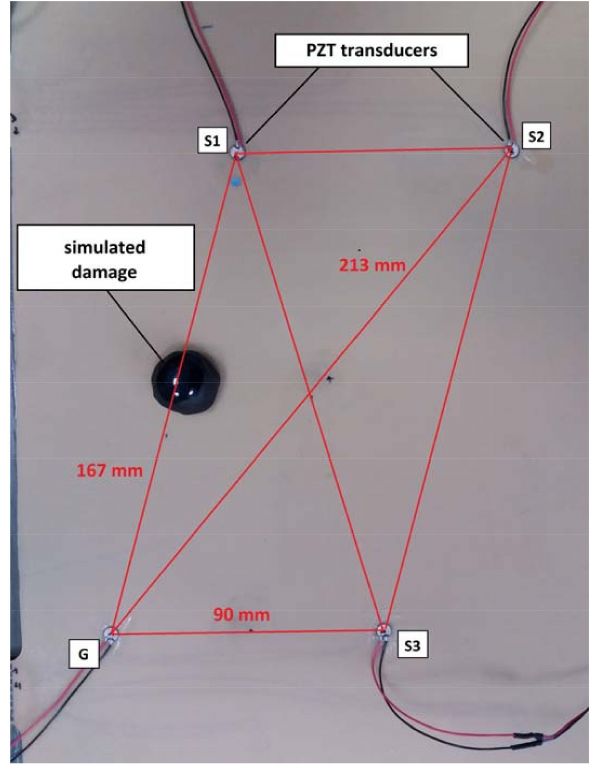
Figure 5. The geometry of the PZT